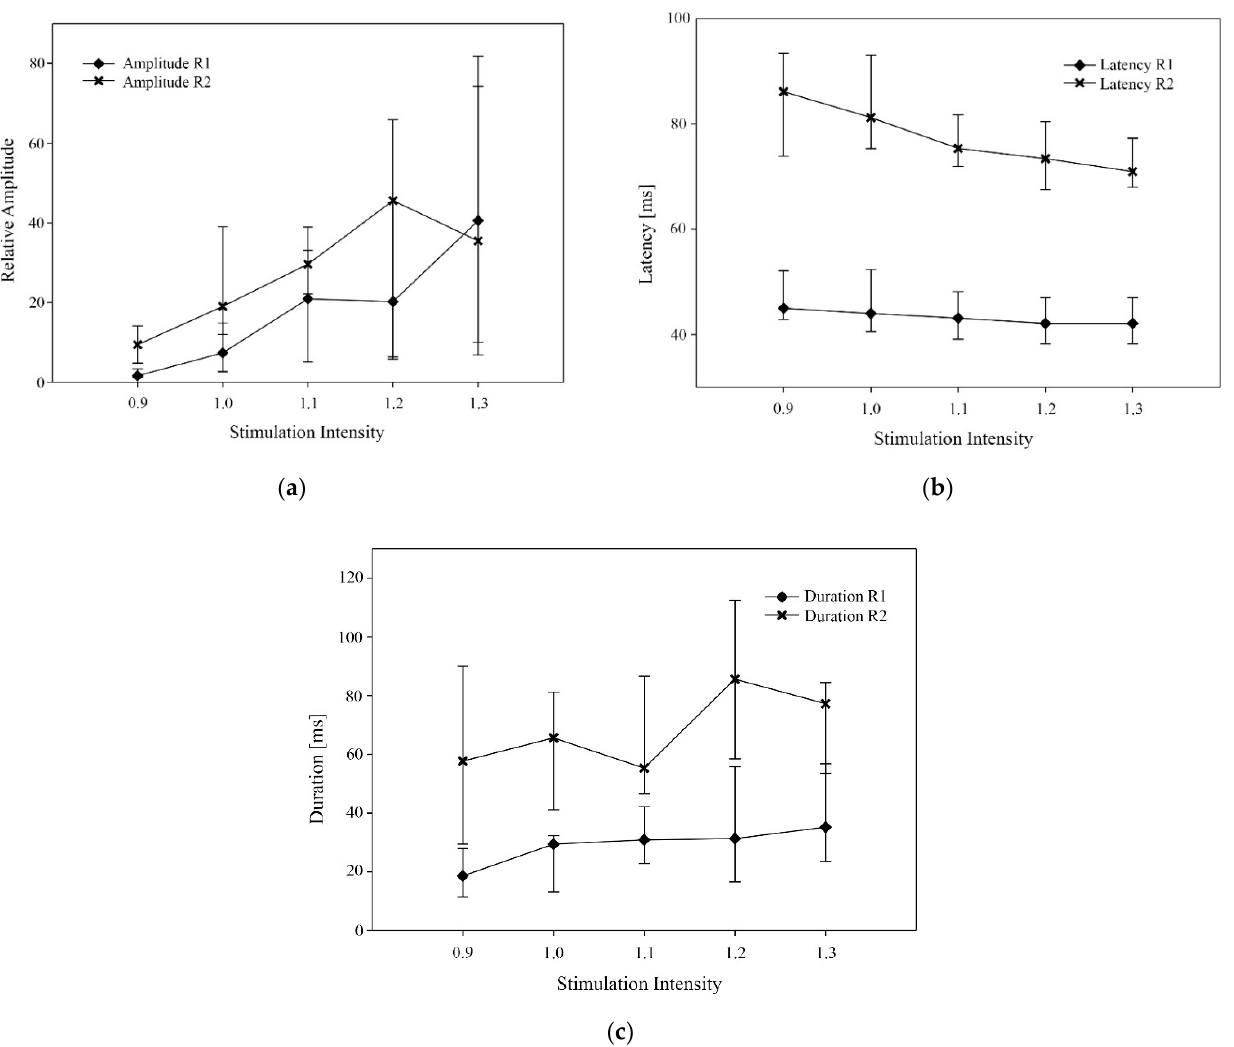
Figure 1. Median value (and interquartile range) of different variables for R1 and R2 at different stimulation intensities (0.9, 1.0, 1.1, 1.2 and 1.3 times the nociceptive withdrawal reflex threshold value). ( a ) relative amplitude, ( b ) onset latency (ms), ( c ) reflex duration (ms).